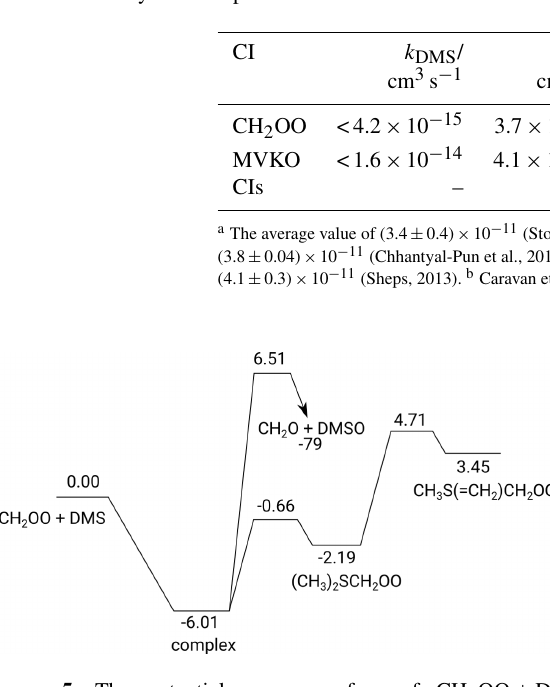
Table 1. Summary of the experimental bimolecular reaction rate coefficients of CI + SO 2 and CI + DMS.